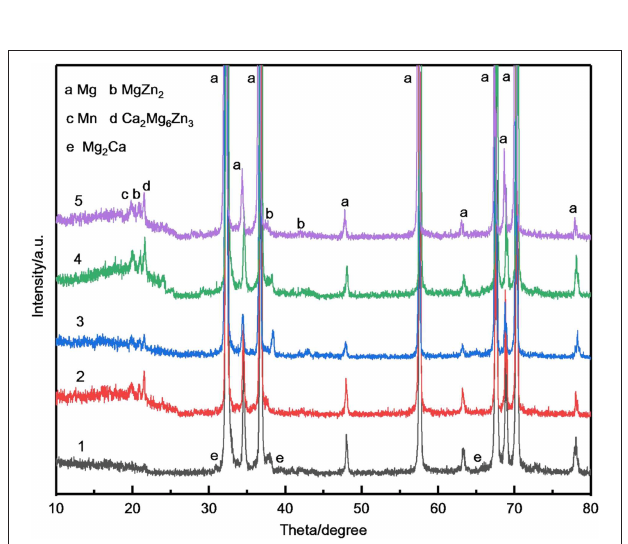
FIGURE 8 | Tensile stress-strain curve of as-extruded MZC, MZC0.3Mn, MZC0.5Mn, MZC0.7Mn and MZC0.9Mn alloys (A) and Local region of tensile stress-strain curve of as-extruded MZC alloy (B)